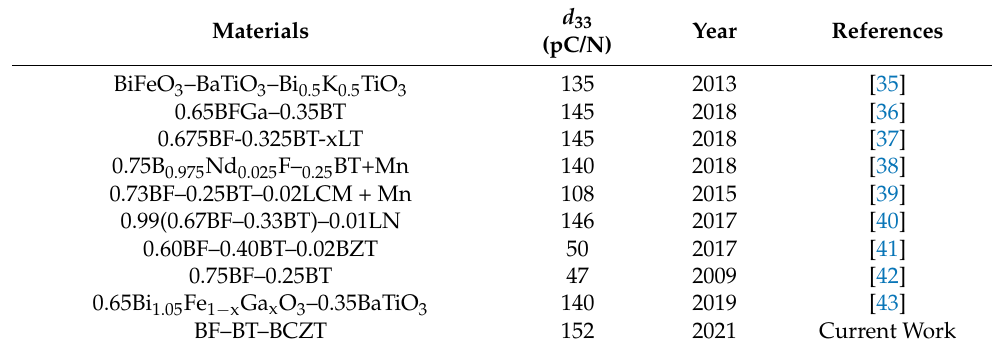
Table 1. Comparison of the piezoelectric constant of various BF-BT